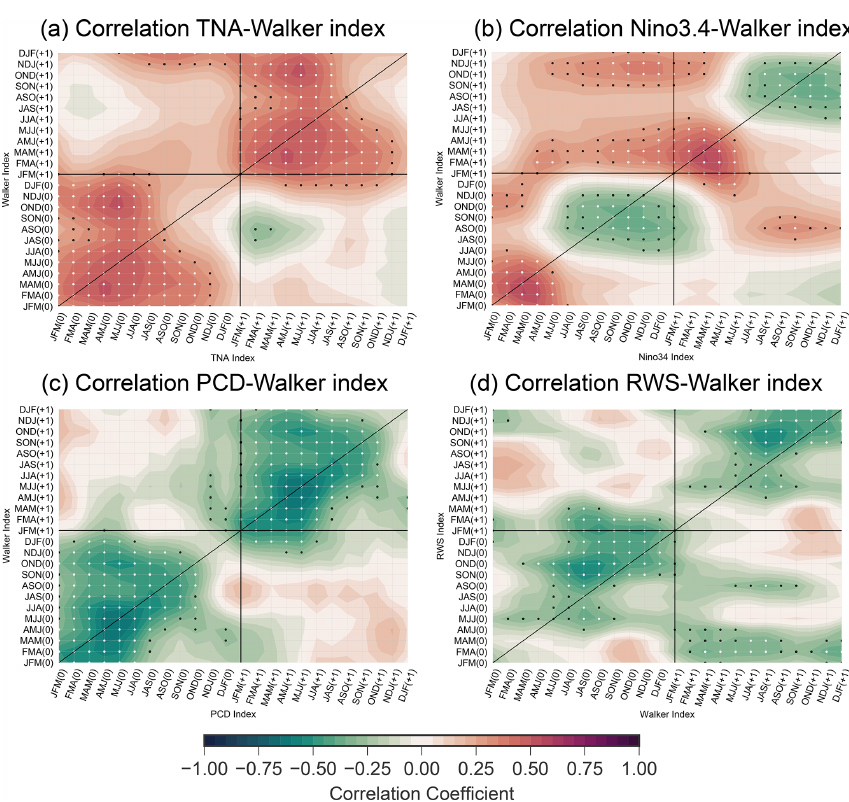
Figure 3. Lead–lag correlation between (a) the Walker index and TNA, (b) the Walker and Niño3.4 indices, (c) the Walker and PCD indices, and (d) the Walker and Caribbean RWS indices. The “(0)” and “( + 1)” refer to the starting year or subsequent year for each index, the diagonal line corresponds to no lag, and values above (below) the diagonal line represent a lead (lag) of the x -axis variable. The black dots represent the 95% confidence interval, and white dots represent the 99% confidence interval. Results are using data from JRA-55